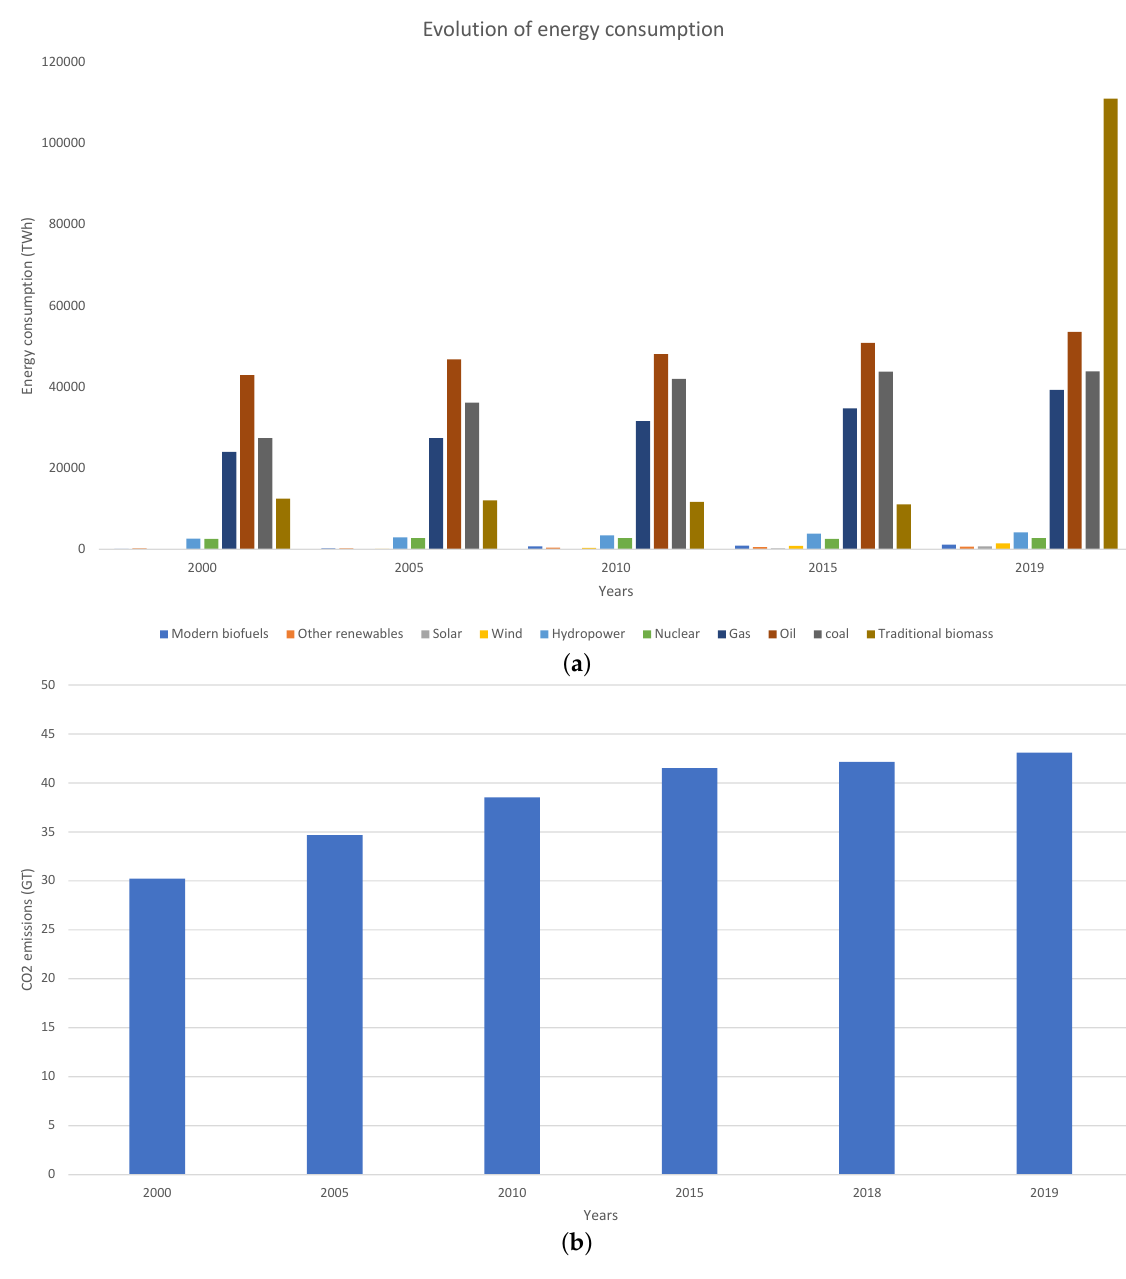
Figure 1. Energy consumption and CO 2 emissions worldwide. ( a ) Evolution of energy consumption [20]. ( b ) Evolution of CO 2 emissions